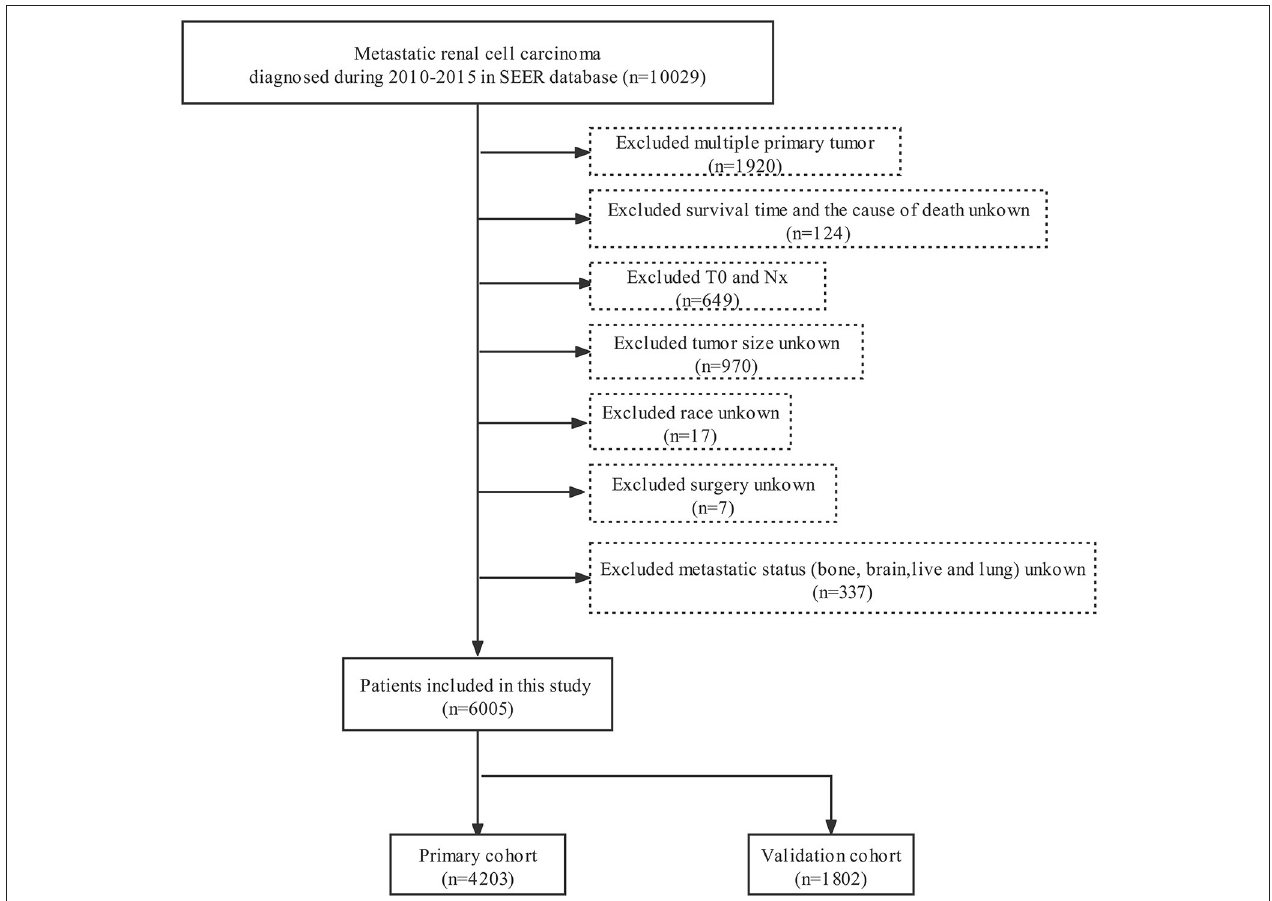
FIGURE 1 | Flowchart for selection of metastatic renal cell